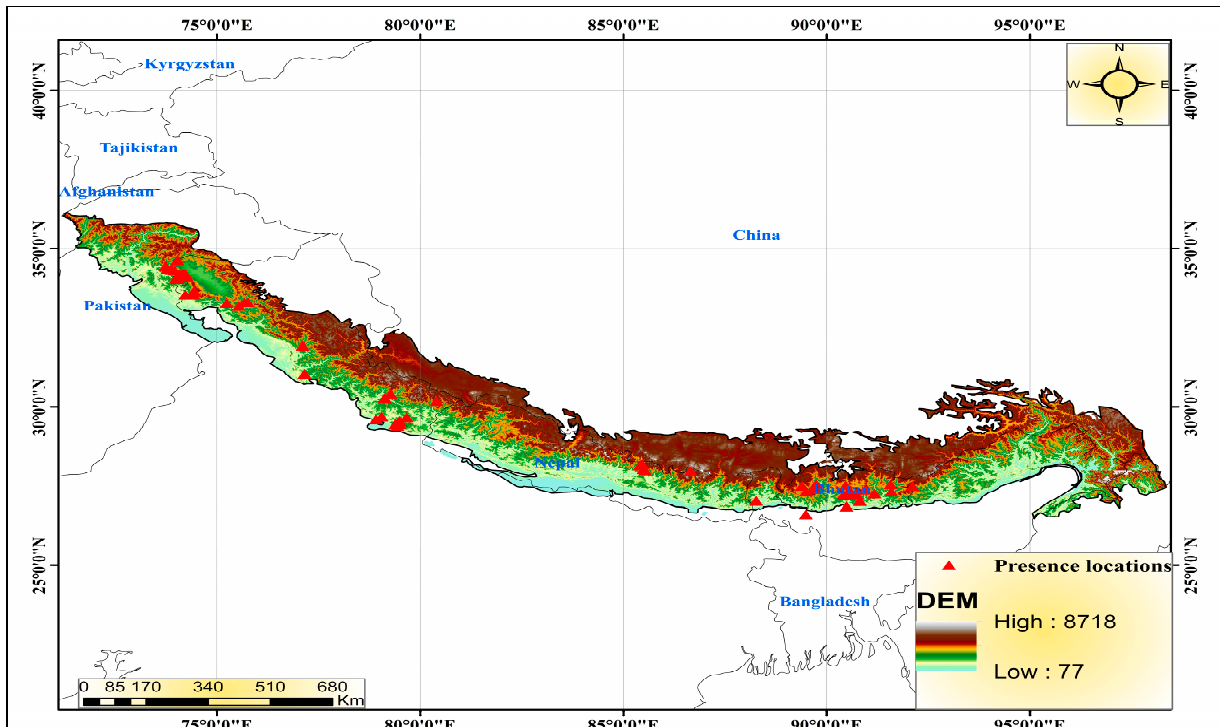
Figure 1. Study area showing the Himalayan mountain range and recorded presence points of the Himalayan goral in South Asia.